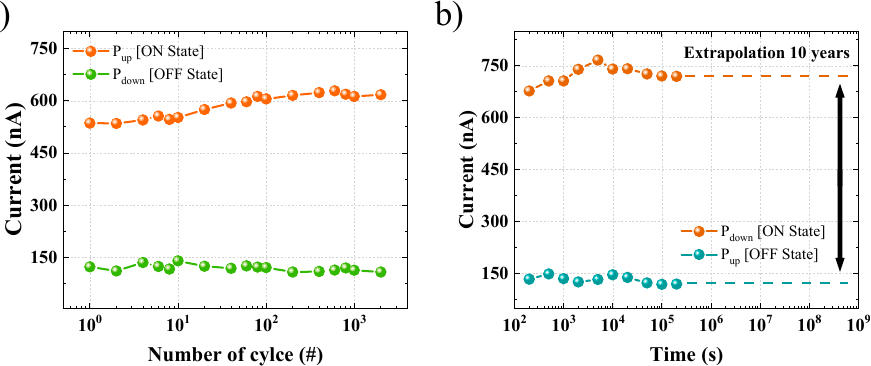
Figure 5. The reliability of the MFIS FTJ device: ( a ) endurance characteristics evaluated by electric field cycling; ( b ) retention characteristics for 10 5 s.